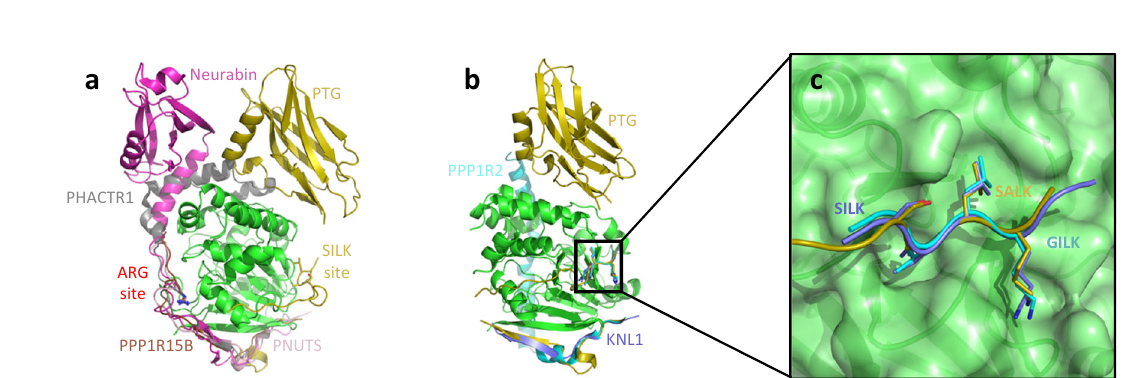
Fig. 4 | Comparison ofPP1 complexes. a Superposition ofPP1 (green) in complex with PTG (yellow), Neurabin (magenta), PHACTR1 (gray), PPP1R15B (brown), and PNUTS(pink). The SILKsite inPTGlocates on anopposite PP1 surface with respect